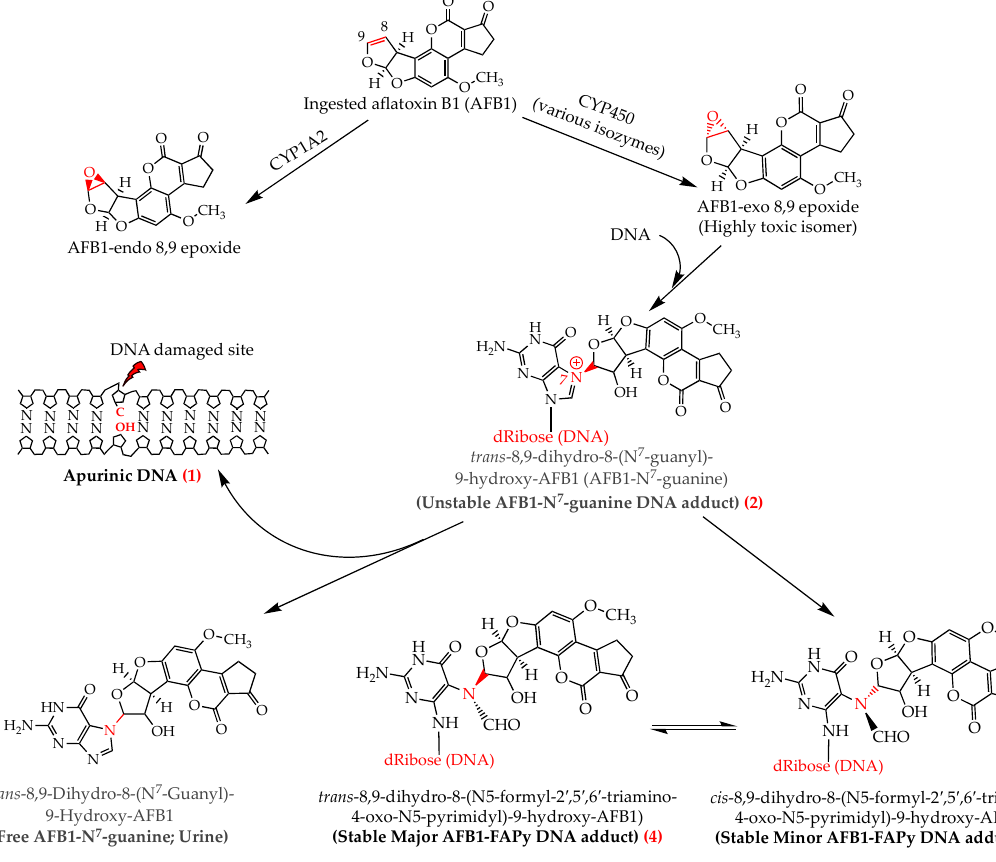
Figure 2. Activation of aflatoxin B1 and its interaction with the DNA leading to the formation of aflatoxin DNA adducts which cause three main DNA lesions, AFB1-N 7 -guanine ( 1 ), apurinic DNA ( 2 ), and AFB1-FAPy ( 3 , 4 ), involved in mutagenicity and carcinogenicity. Upon furan ring opening to stabilize the AFB1-N 7 -gua DNA adduct, the “ cis ” (minor) rotamer ( 3 ) of AFB1-FAPy is formed first and is then transformed into the “ trans ” (major) rotamer ( 4 ) to an equilibrium where the major rotamer is predominating (2:1; major to minor ratio) [52].